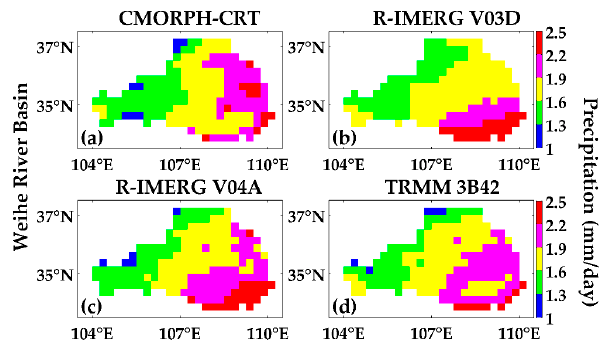
Figure 11. Spatial distribution of mean daily precipitation (mm/day) at 0.25° resolution between 1 June 2014 and 30 November 2015 derived from CMORPH-CRT ( a ); R-IMERG V03D ( b ); R-IMERG V04A ( c ); and TRMM 3B42 ( d ) over the Weihe River Basin.